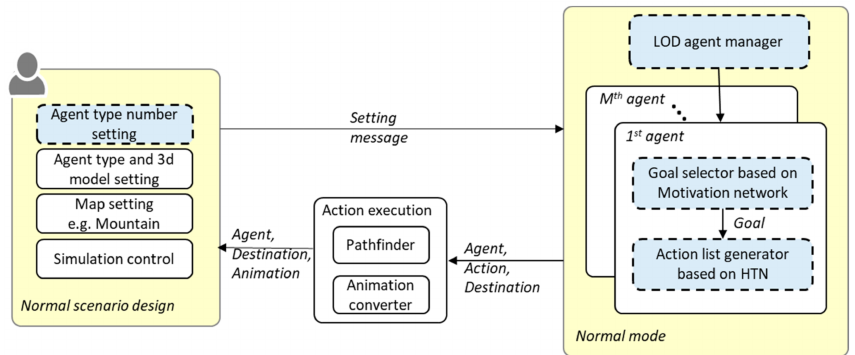
Figure 2. Overview of the normal mode. LOD: level of detail; HTN: hierarchical task